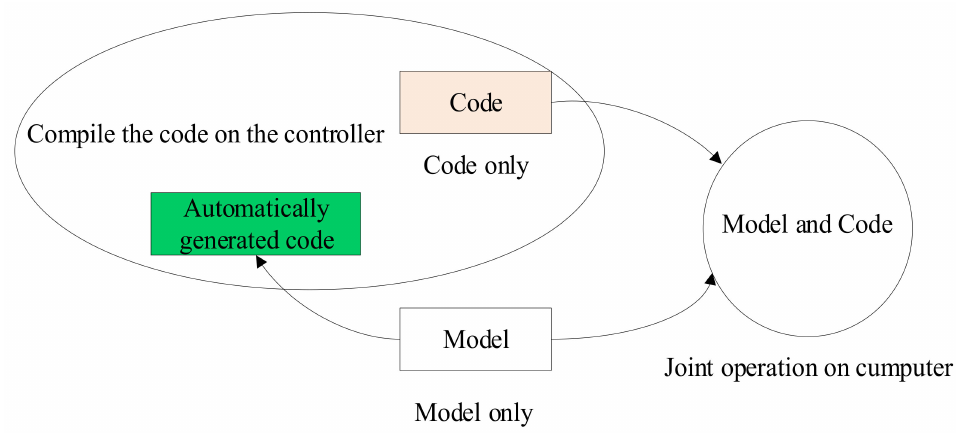
Figure 3. Model and code from independence to